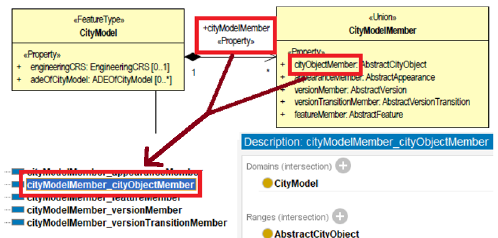
Figure 2. UML Union Flattening example with